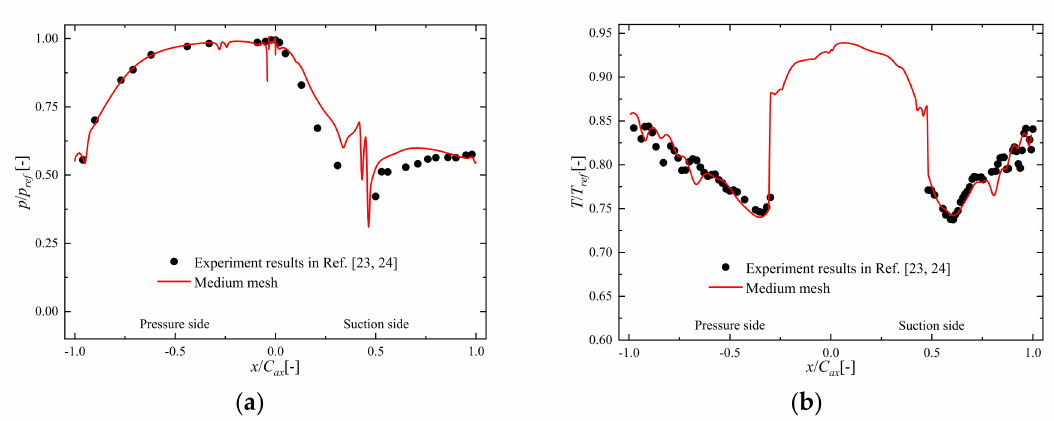
Figure 3. Comparisons of numerical results with experimental results [23,24]. ( a ) Pressure profile; ( b ) Temperature